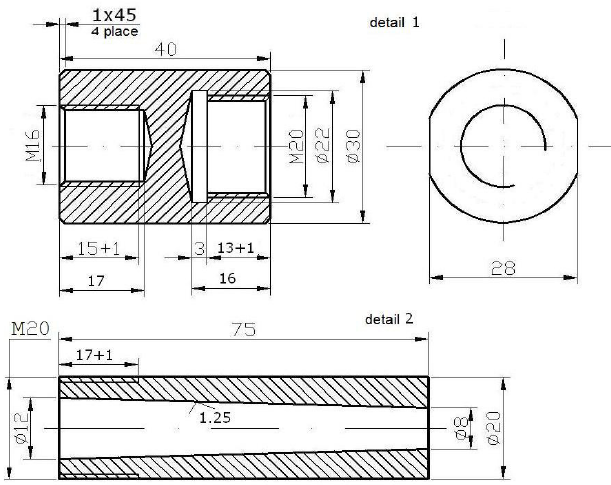
Figure 3: Scheme of device for unidirectional rod specimen testing at high temperatures [3] Types of diagrams of unidirectional fiberglass (Direct "E" roving 0.7 - orthophthalic polyester resin 0.3) deformation in tensile test at various temperatures came out similar. On Fig. 4 is shown typical diagram of unidirectional fiberglass deformation in tensile test with usage of videoextensometer Instron AVE.